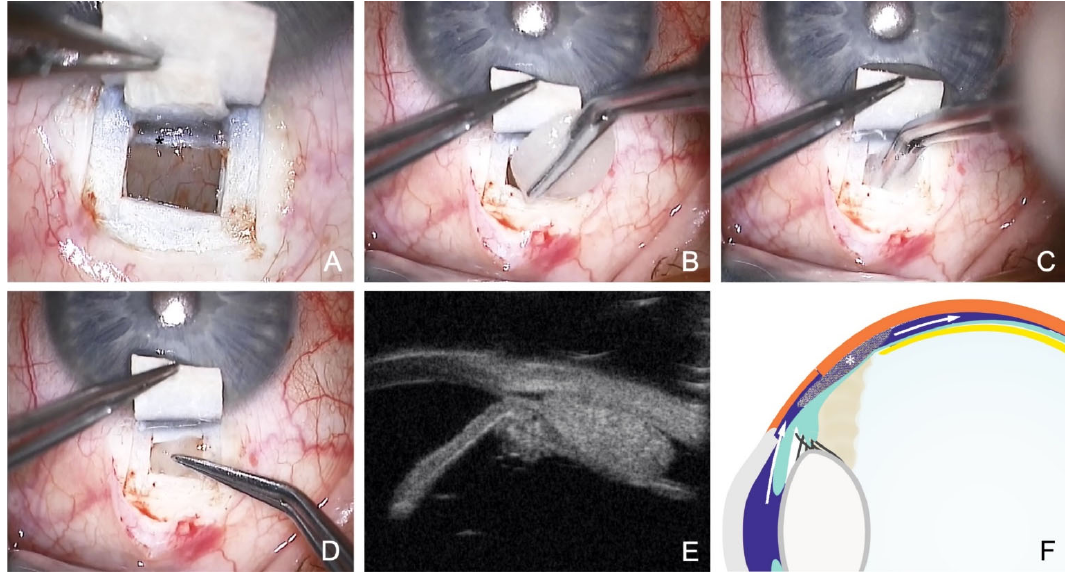
Figure 6. Canaloplasty with ScD and suprachoroidal Ologen sponge. ( A ) Clearly visible choroidal window, the scleral spur (Asterisk) and the TDW anterior to the scleral spur. ( B ) 6 mm Ologen sponge. ( C ) Suprachoroidal implantation of Ologen through the choroidal window. ( D ) Positioning of the Ologen as a placeholder in the suprachoroidal space, keeping the drainage open. ( E ) UBM imaging (50 MHz) of the implanted Ologen; note the suprachoroidal fluid around the implant. ( F ) Schematic showing the mechanism of ScD fluid circulation (arrows) and suprachoroidal Ologen (asterisk). Also marked are the scleral spur (star) and the ciliary body